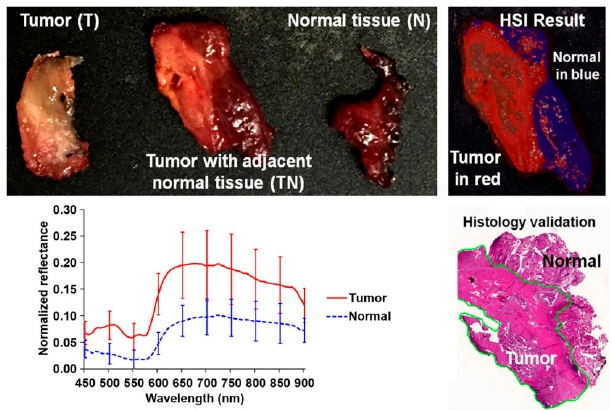
Figure 8. Preliminary results obtained in the tumor margin delineation for head and neck cancer [138]. After hyperspectral image acquisitions (top ‐ left), the tissue was processed histologically, and tumor margins were outlined on the pathology image (bottom right) by a pathologist, which was used to validate the results of the classification (top ‐ right). The average spectral curves are shown at the bottom left for each type of tissue, i.e., tumor, normal, and tumor with adjacent normal tissue. Reproduced from [138]; Creative Commons BY 4.0; published by SPIE (2017).